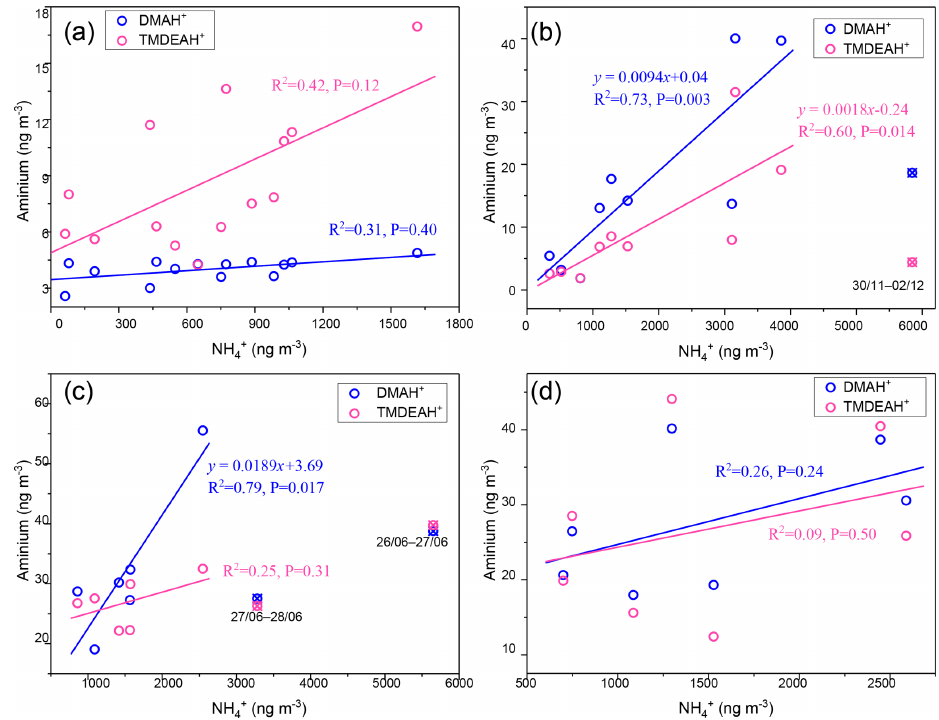
Figure 10. Correlations between aminiums and NH + concentrations over Huaniao Island for each campaign: (a) in the summer of 2016, 4 (b) in the autumn of 2016, (c) in early summer 2017, and (d) in late summer 2017.